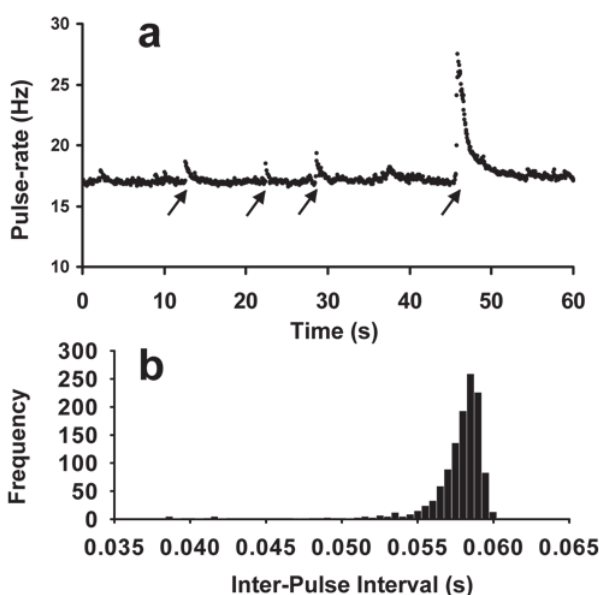
Fig. 3. a. Resting diurnal Electric Organ Discharge (EOD) rep- etition rate of a single specimen of Brachyhypopomus draco (UFRGS 6487). Repetition rate in Hz (pulses per second) is plotted for a 60 s recording. Each point represents the dis- tance from an EOD to the preceding one (Inter-Pulse Interval, IPI). Note the intermittent upward modulations of repetition rate (arrows) in response to disturbances such as minute vi- brations. These ‘novelty responses’ are a normal part of EOD activity in the wild. b. Histogram of 1218 IPIs for the 60 s recording, exhibiting a typical right-skewed distribution due to the novelty responses. Repetition rate (Hz) is the recipro- cal of Inter-pulse interval ( e.g. 1/20 Hz = 0.05